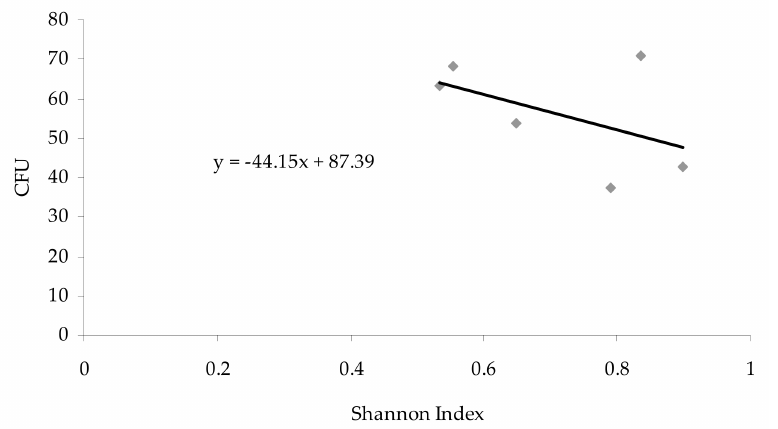
Figure 5. Relationship between the number of airborne fungal spores (CFU 1 m − 3 of air) and Shannon index in the Brestovsk á Cave (the Pearson correlation coefficient: p < 0.05; r = −